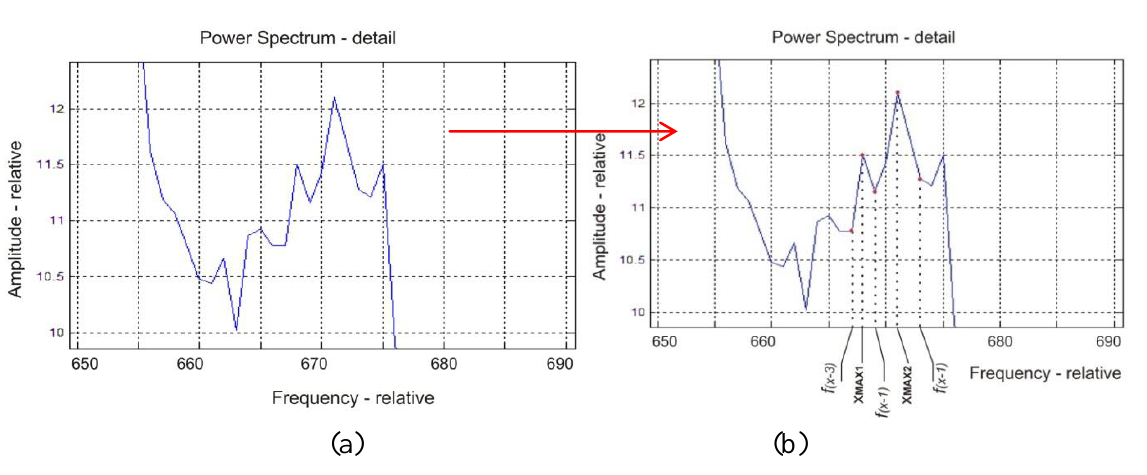
Figure 5. (a) Detail of point in PS. (b) False maximum during application of simple algorithm for finding